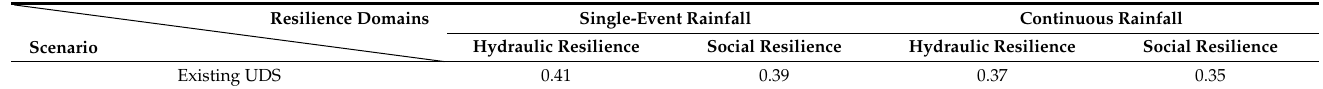
Table 8. The calculated resilience index by IMPRESS methodology for various resilience